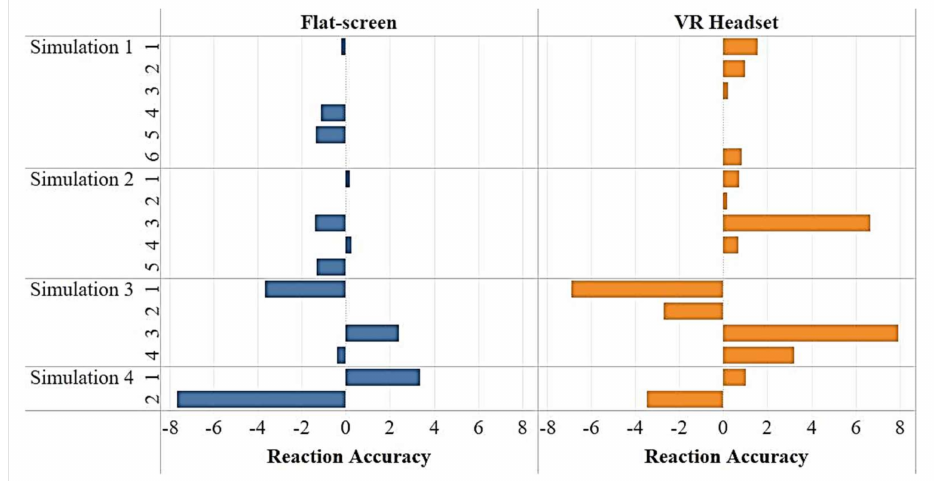
Figure 8. Effect of display–type on reaction accuracy.